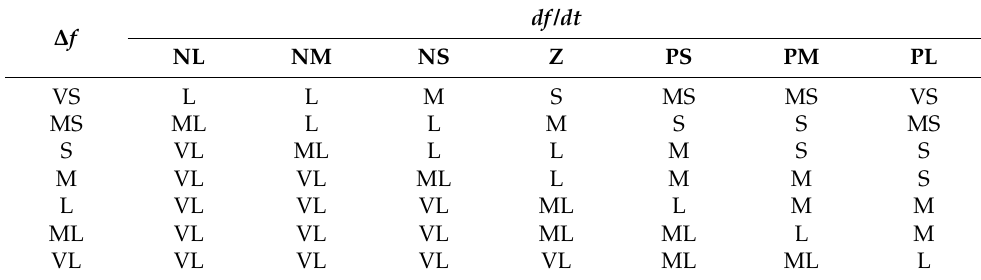
Table 1. The rules of